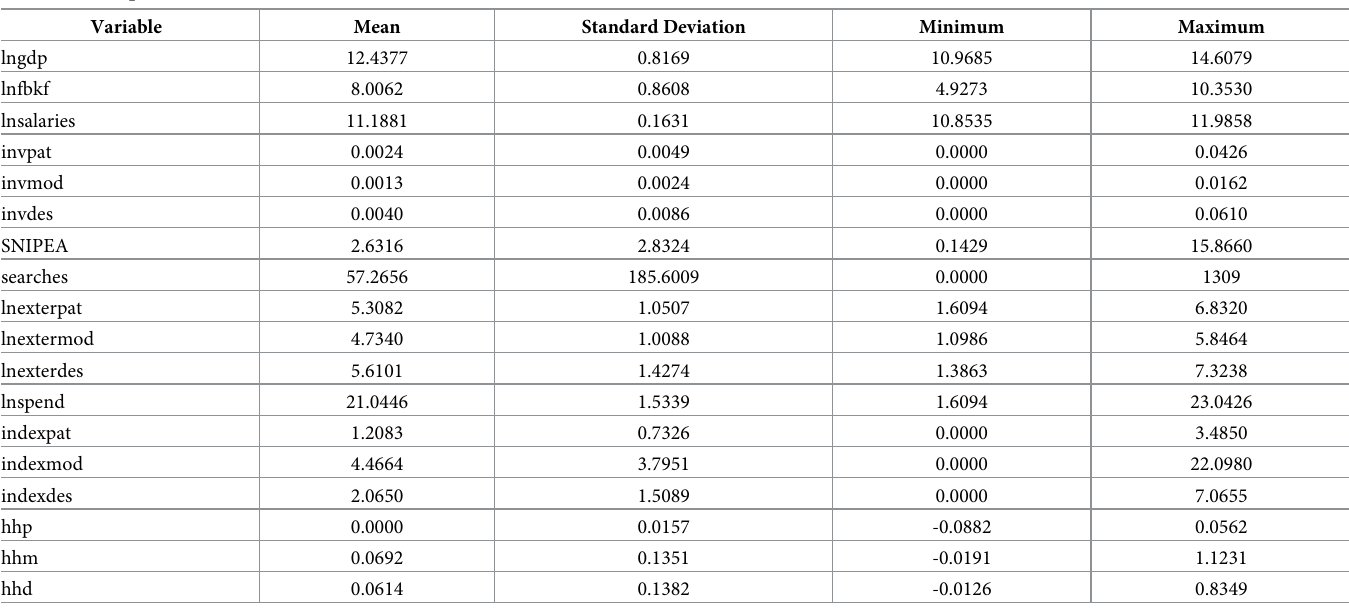
Table 3. Descriptive statistics of the